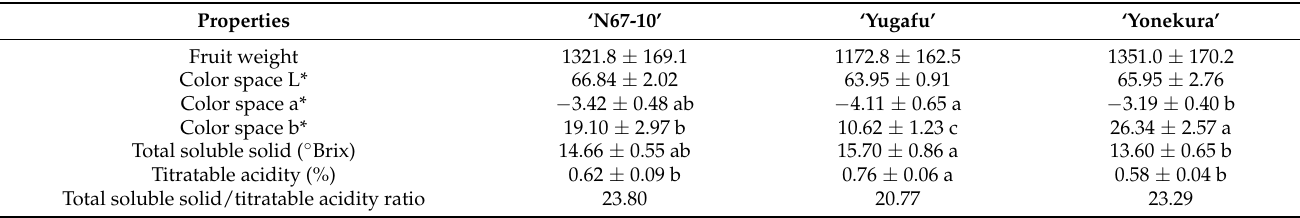
Table 1. Physicochemical properties of Okinawan